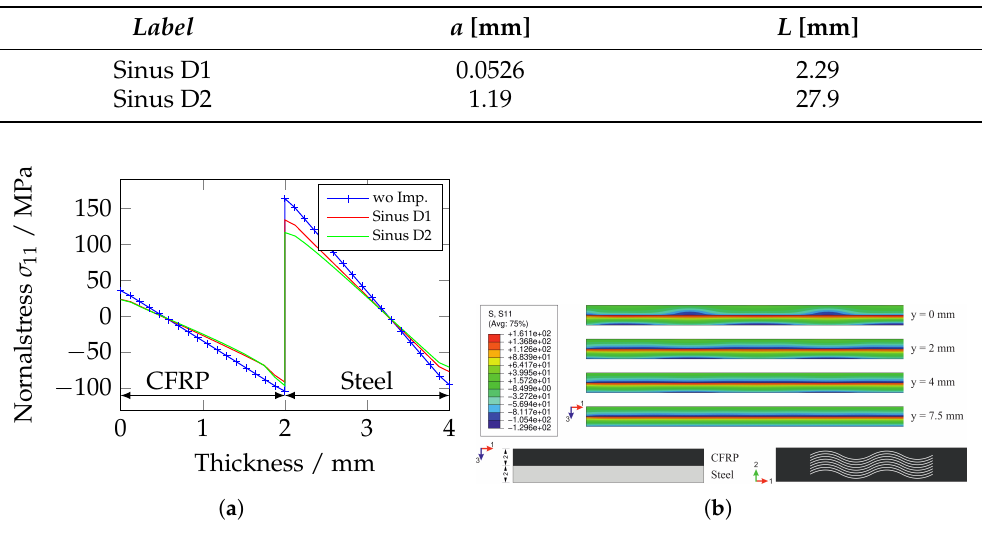
Figure 5. ( a ) Residual stress states with an in-plane fiber waviness compared to the reference residual stress state (without any imperfections). ( b ) Contour plot of the residual stress distribution σ 11 shown for four section planes. The oscillation of the residual stress in thickness direction decreases rapidly from the boundary (y = 0mm), after 2mm the oscillation is almost absent.